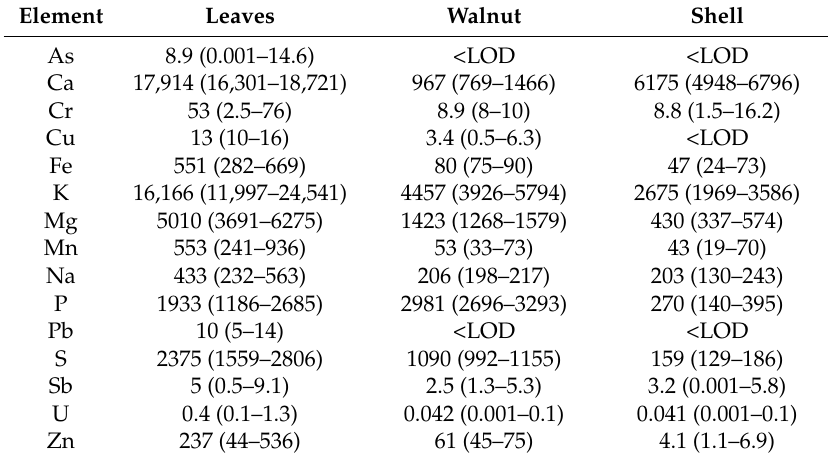
Table 3. Averages of elemental content (range; mg/kg) in leaves, walnut, and shells samples. Element Leaves